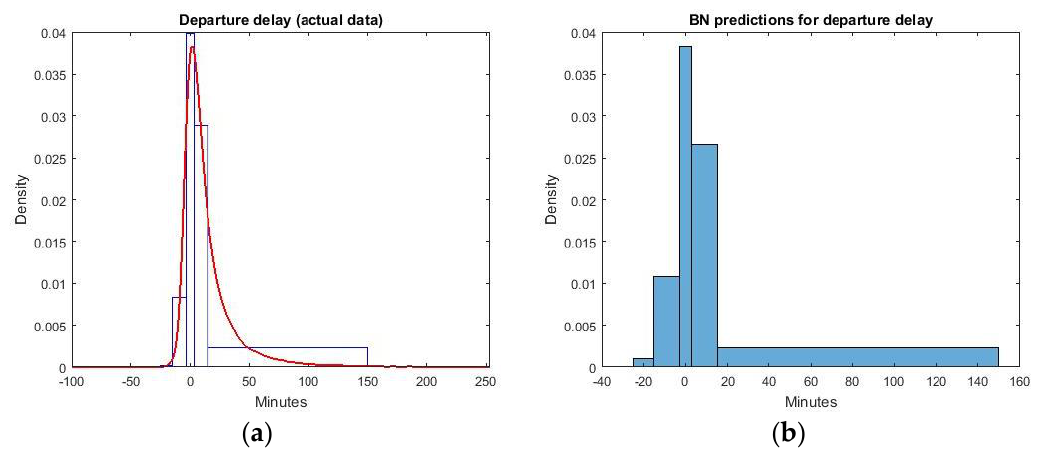
Figure 24. Histograms for departure delay: ( a ) actual data; ( b ) BN predictions.